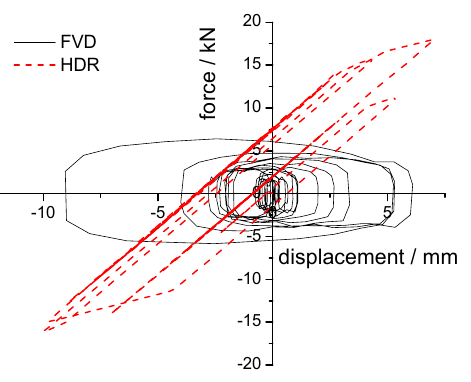
Figure 17. Relative displacement time history curve between side pier and girder of the CFVD system.